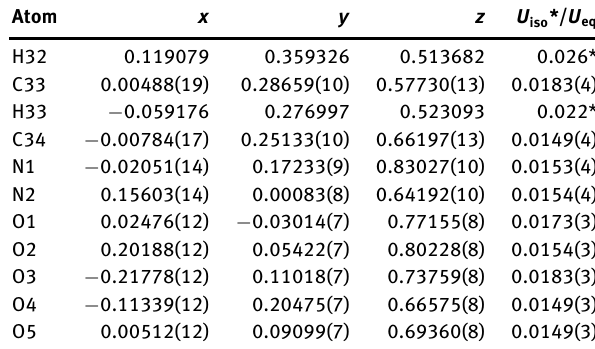
Table 2: Fractional atomic coordinates and isotropic or equivalent isotropic displacement parameters (Å 2